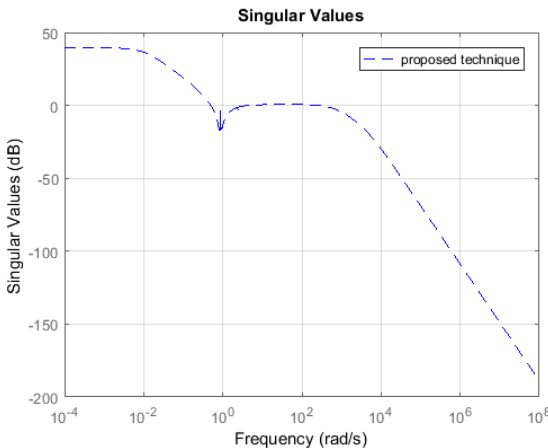
Figure 12. Sigma plot of 𝐾 𝑟 (s)𝑃(𝑠).